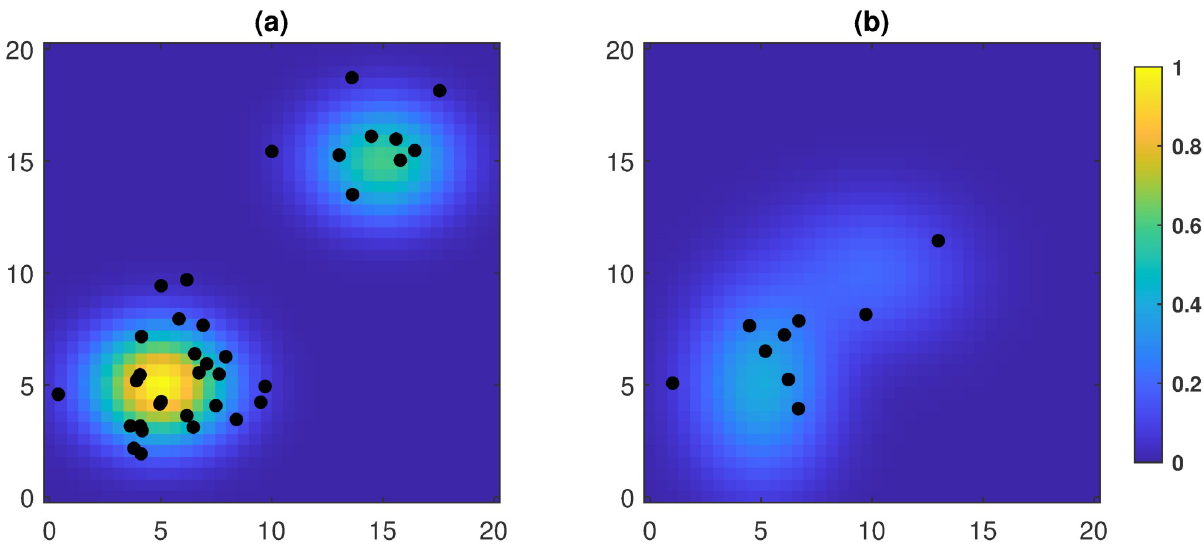
Fig 3. Samples from IPPs with a mixture of squared exponential intensity function ( p = 2). (a) A sample corresponds to C 1 = 1.0, C 2 = 0.6, ( a 1 , b 1 ) = (5, 5), ( a 2 , b 2 ) = (15, 15), and ( h 1 , l 1 ) = ( h 2 , l 2 ) = (3, 2). (b) A sample corresponds to C 1 = 0.4, C 2 = 0.2, ( a 1 , b 1 ) = (5, 5), ( a 2 , b 2 ) = (10, 10), ( h 1 , l 1 ) = (3, 4), ffiffiffiffiffi p and ð h ; l Þ ¼ ð 4 ; 10 Þ 2 2